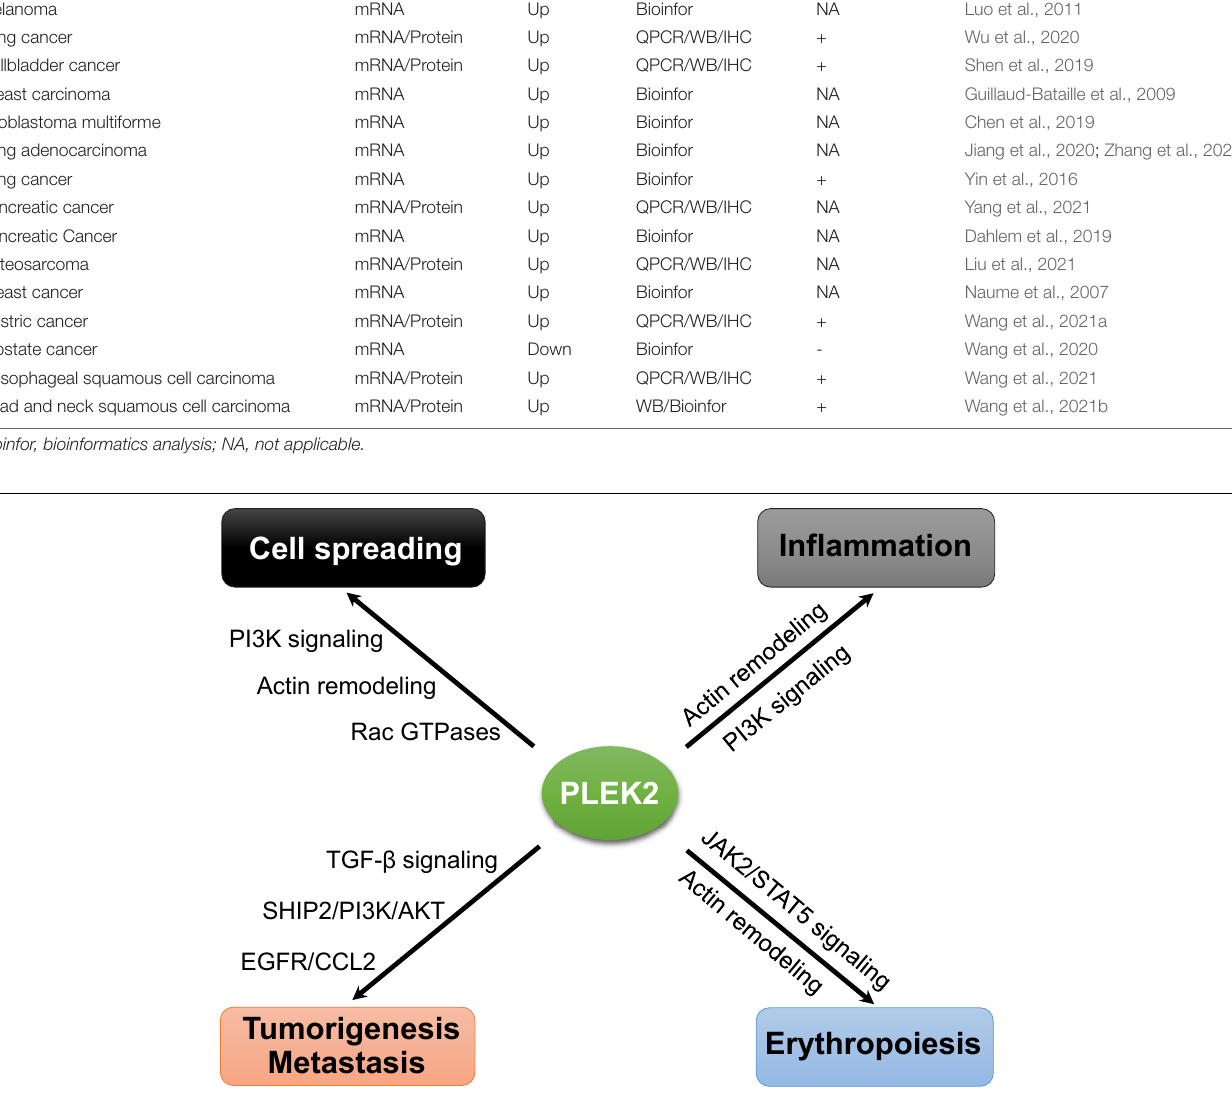
also involved in osteosarcoma tumorigenesis (Liu et al., 2021) and metastasis and in self-renewal and proliferation of pancreatic cancer stem cells (Yang et al.,